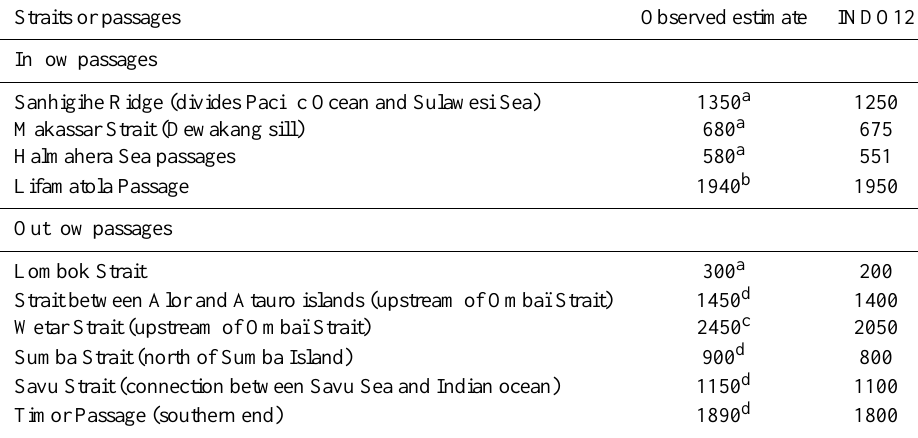
Table 1. Sill depths (m) of the key straits and passages in the Indonesian seas from the scientific literature and those used in INDO12. Straits or passages